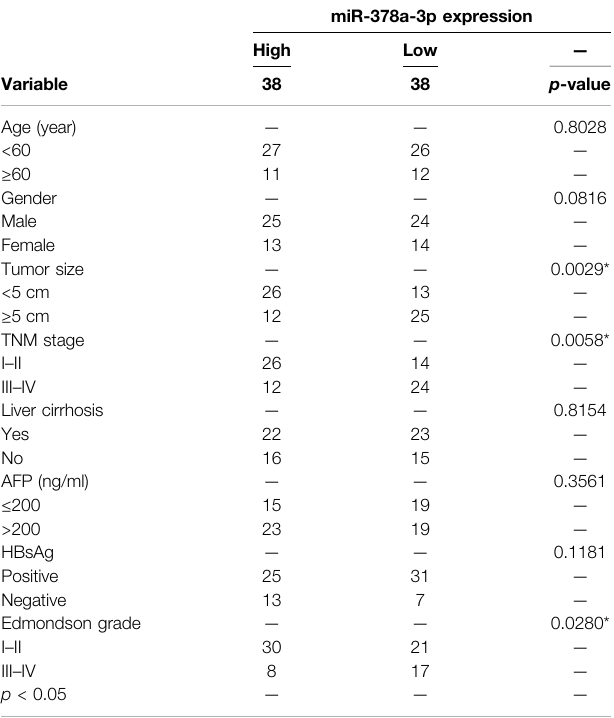
TABLE 2 | Correlation between miR-378a-3p expression and clinicopathological features in HCC tissues ( n (cid:2) 76, χ 2